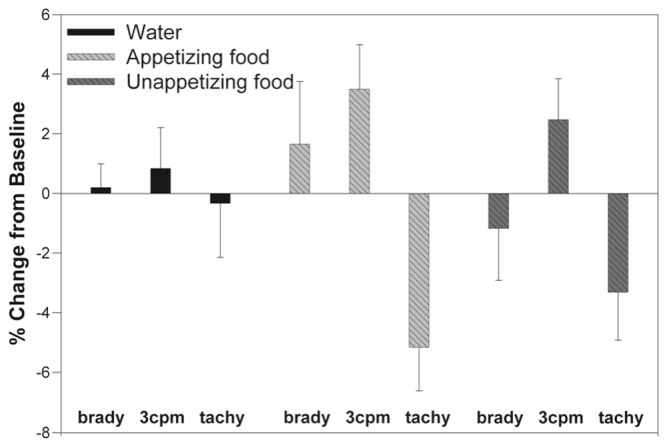
Change in EGG dominant power in three frequency bands (percent bradygastria, normogastria, tachygastria) from baseline during hypnosis.As can be seen, the response to a water load (left) is multiplied during imagining of an appetizing meal (middle) specifically in the tachygastria band, while it is less with the unappetizing meal (right). Note that error bars are understood to extend in both directions symmetrically.